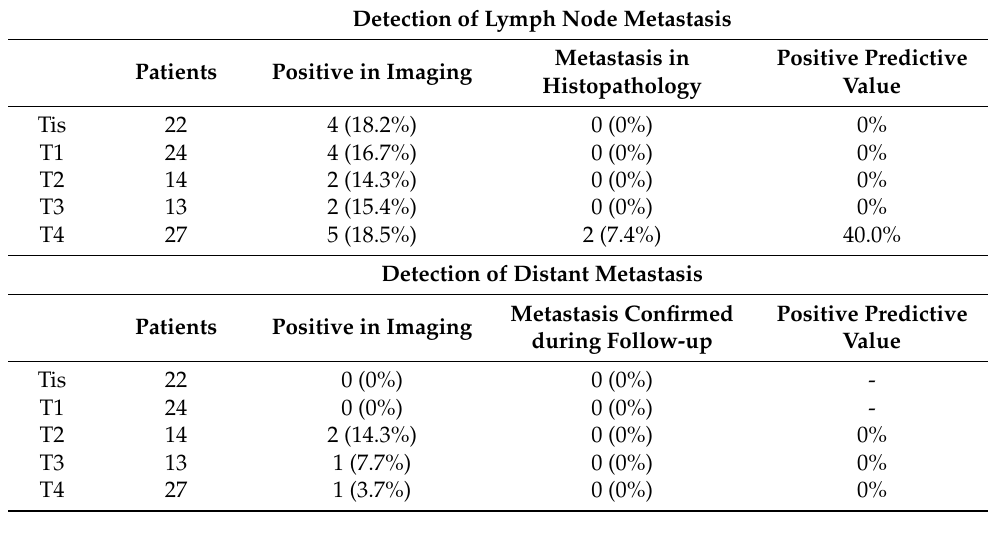
Breslow thickness (T category) and metastasis detection in 100 patients without